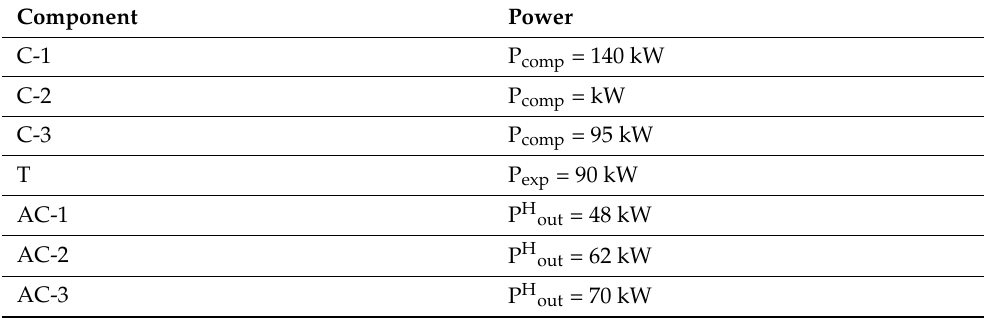
Table A12. This power data refer to operating unit in AC-2.